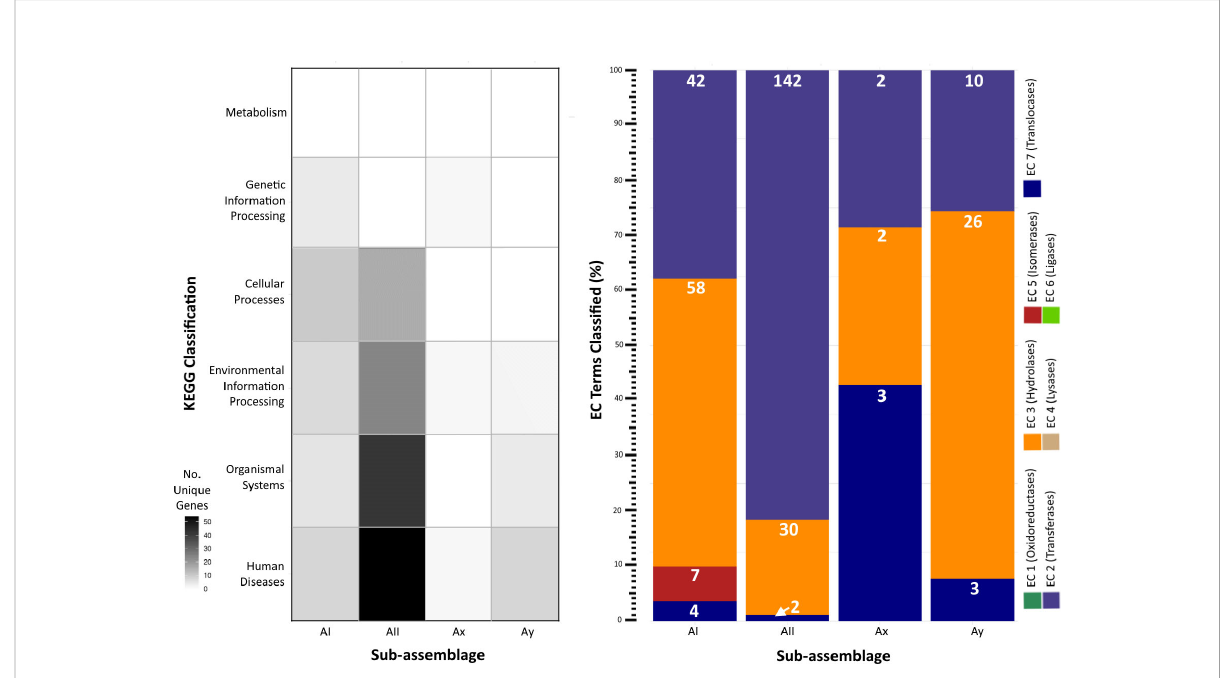
FIGURE 4 Functional pathway annotations of unique genes per sub-assemblage. Left: Heatmap of unique genes assigned to KEGG categories. Darker shading indicates greater number of unique gene content annotated to a given category. Right: Stacked bar chart of the percent distribution of EC terms applied to genes unique to a given sub-assemblage (some genes have multiple associated KEGG and/or EC terms, enumerated individually here). White numbers on each bar segment re fl ect the frequency count of each EC category per